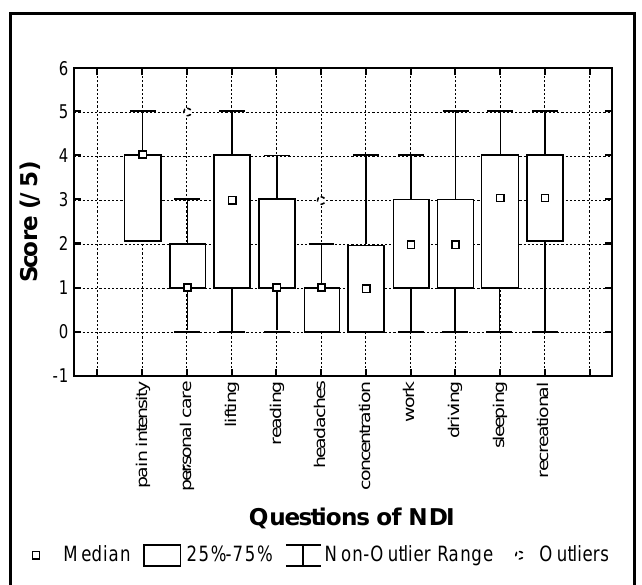
Figure 1: Impact of CR on ability to perform activities of daily living as indicated by scores obtained from NDI (2D Box